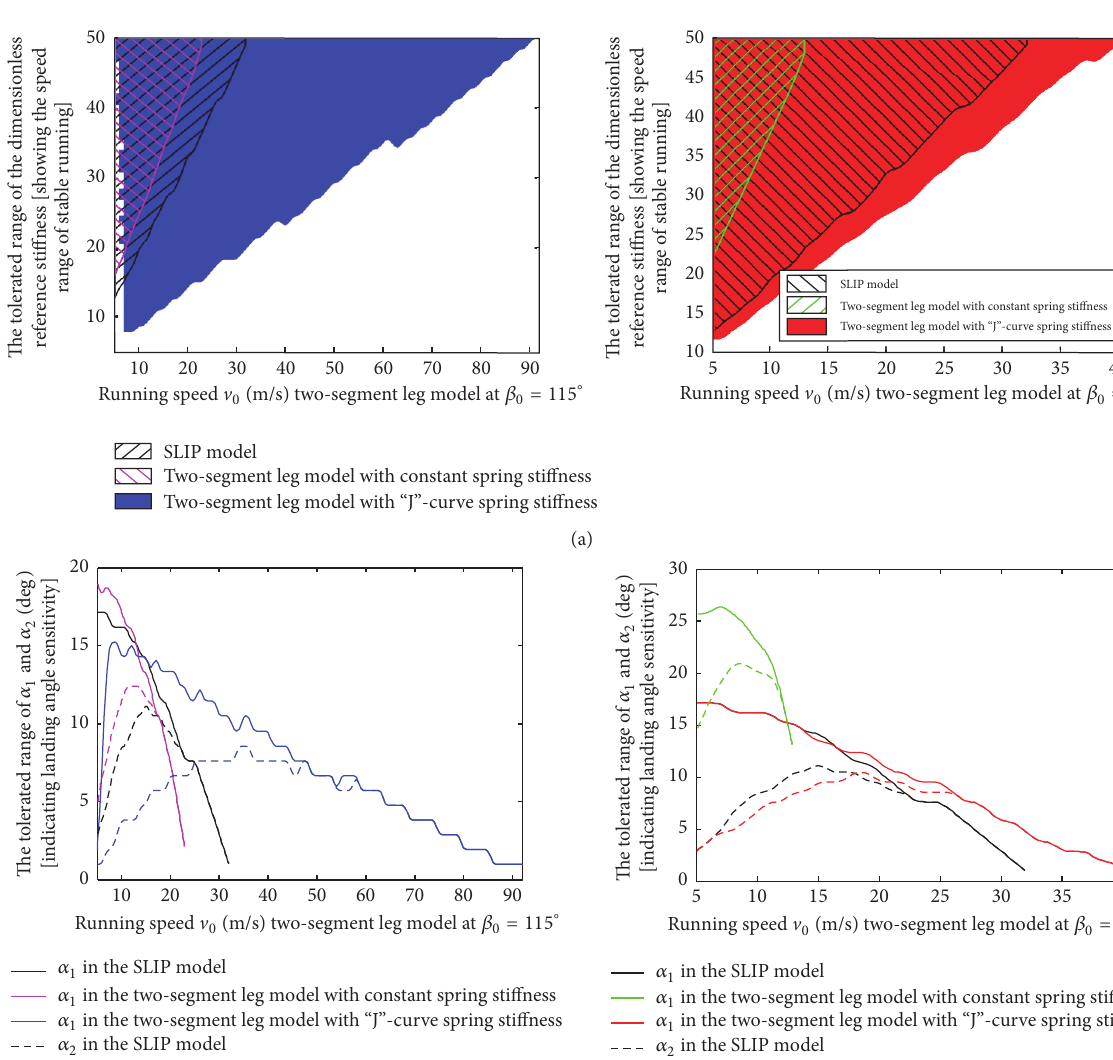
SLIP model stiffnessTwo-segment leg model with constant spring stiffness Two-segment leg model with “J”-curve spring